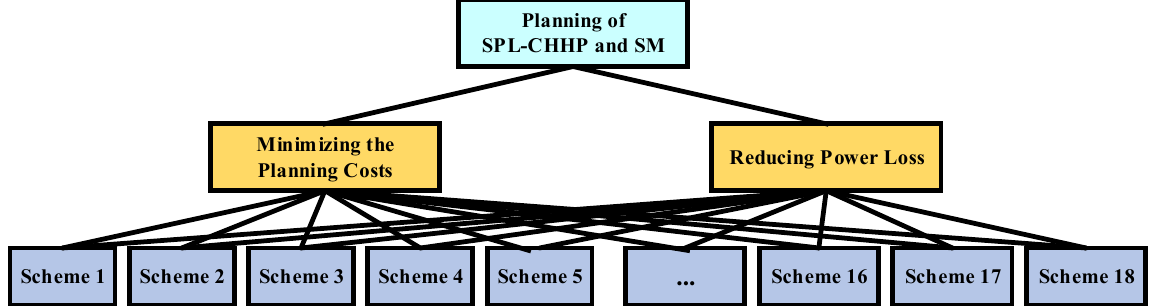
Figure 17. TOPSIS employed in the planning of SPL-CHHP.